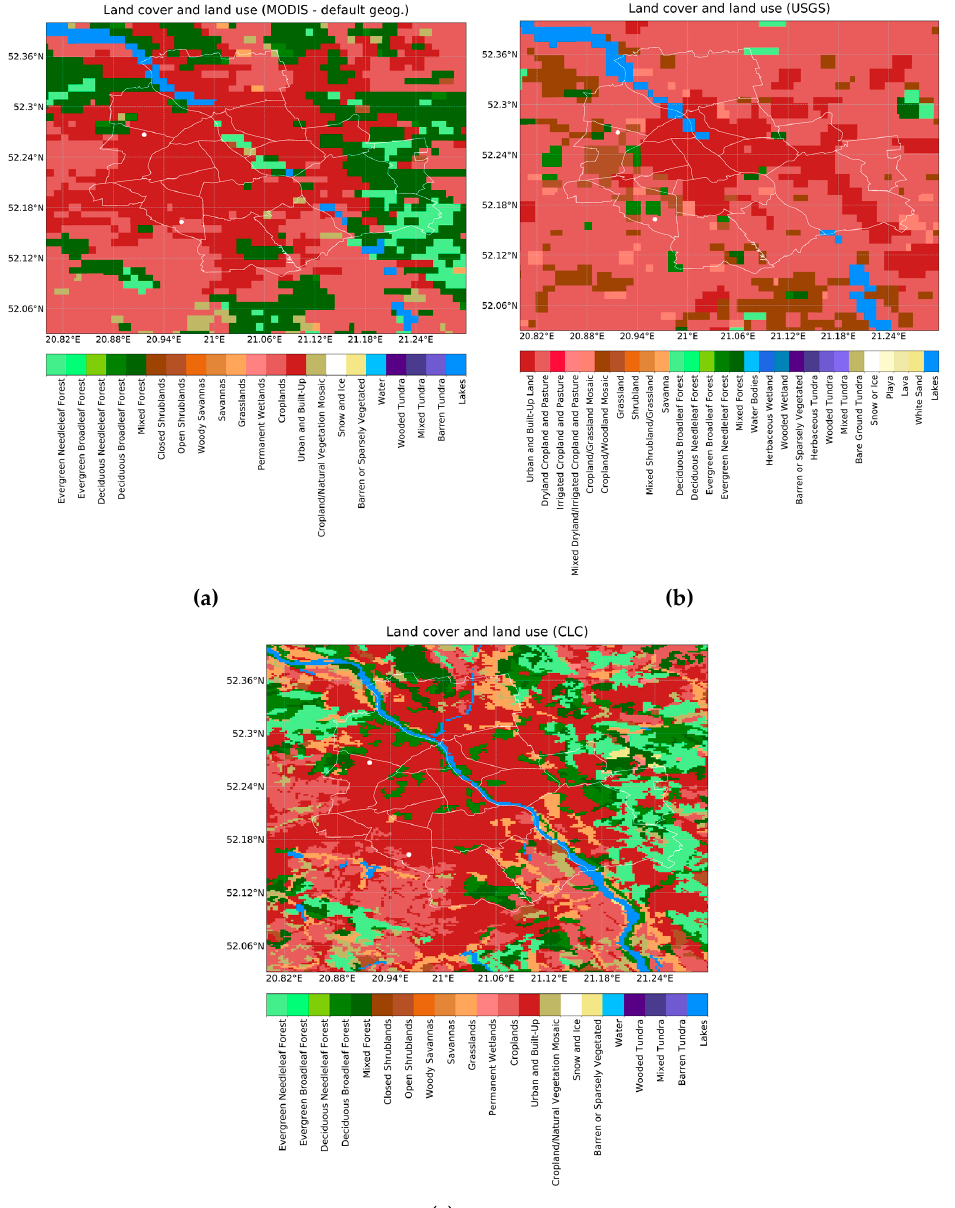
Figure 2. Comparison between land use and land cover data in the WRF model simulations for Warsaw, domain 3 (200 × 200 m) and: ( a ) MODIS (used as default geog.) data; ( b ) USGS data; ( c ) CLC data.